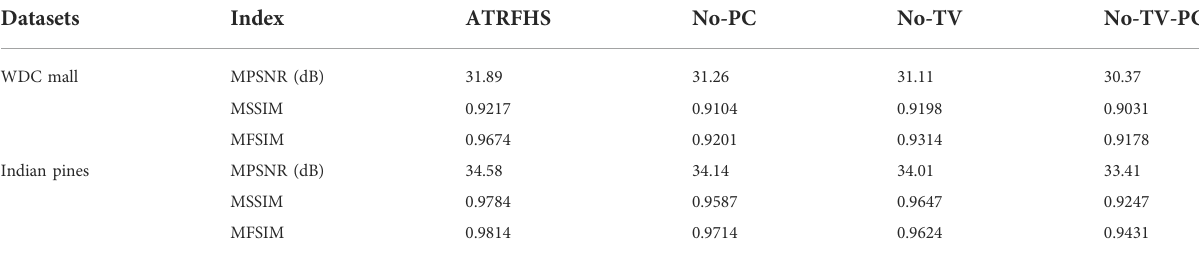
TABLE 4 Empirical analysis of each regularizer of the ATRFHS model.